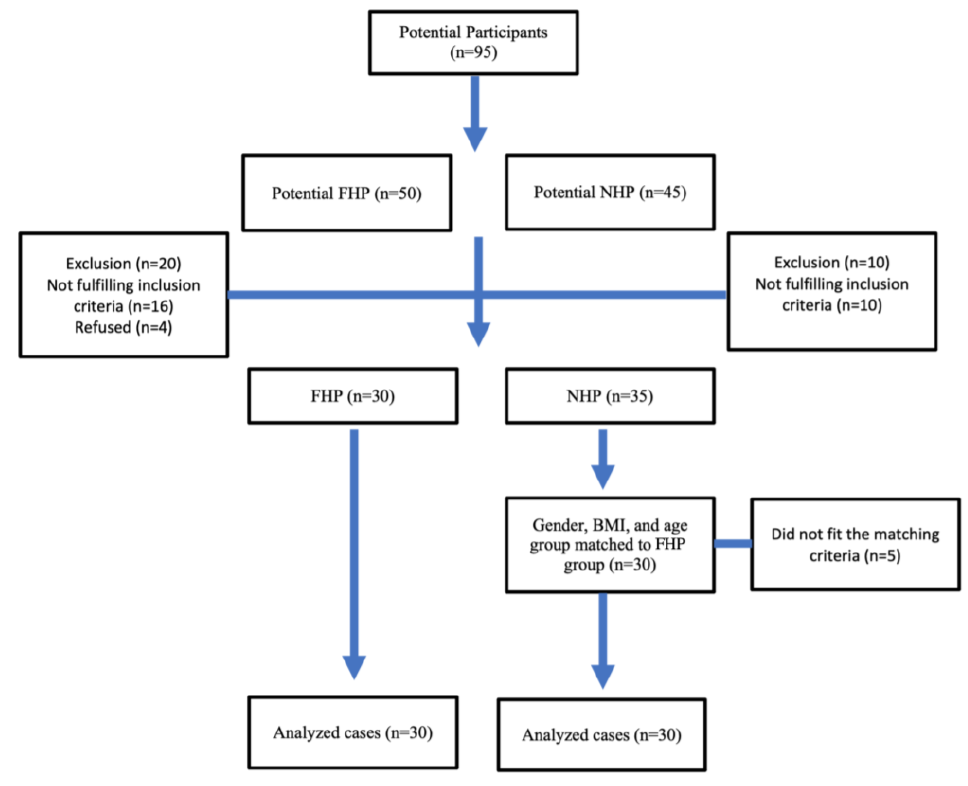
Figure 4. Participant flowchart.